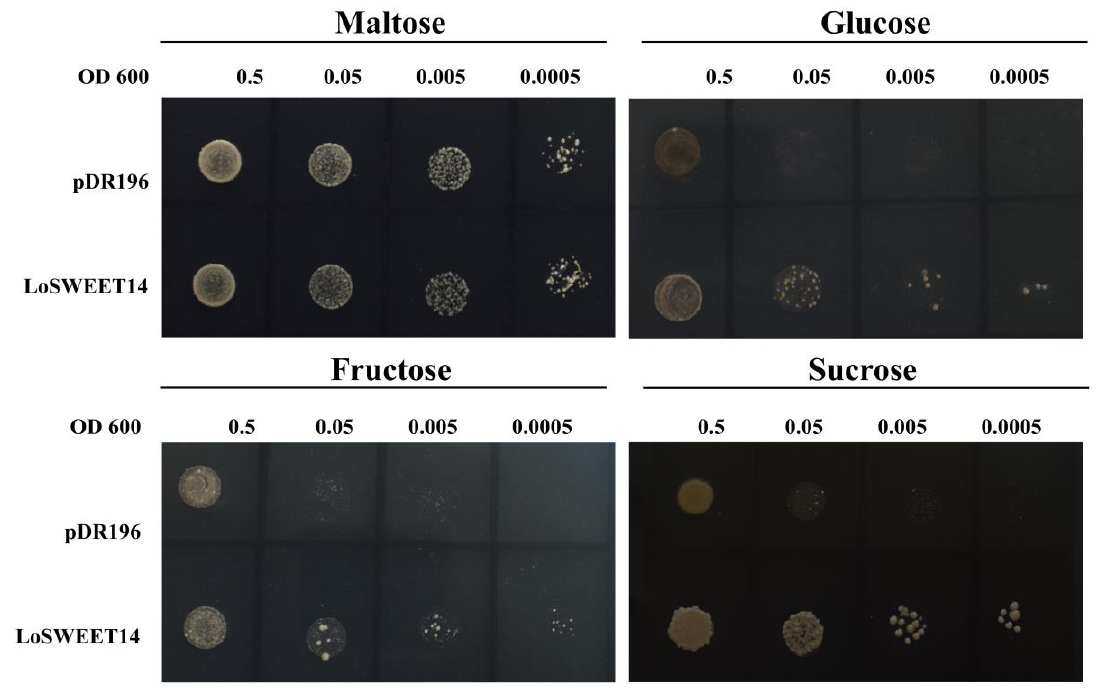
Figure 2. Sugar transport ability of LoSWEET14. Growth of blank pDR196 and LoSWEET14-pDR196 transformed yeast on the SD/ − Ura media supplemented with 2% maltose, 2% glucose, 2% fructose, and 2% sucrose.